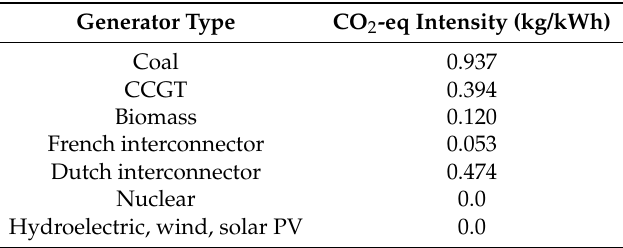
Table 1. Short-run CO 2 -equivalent intensities of the most common generator types feeding into the UK grid